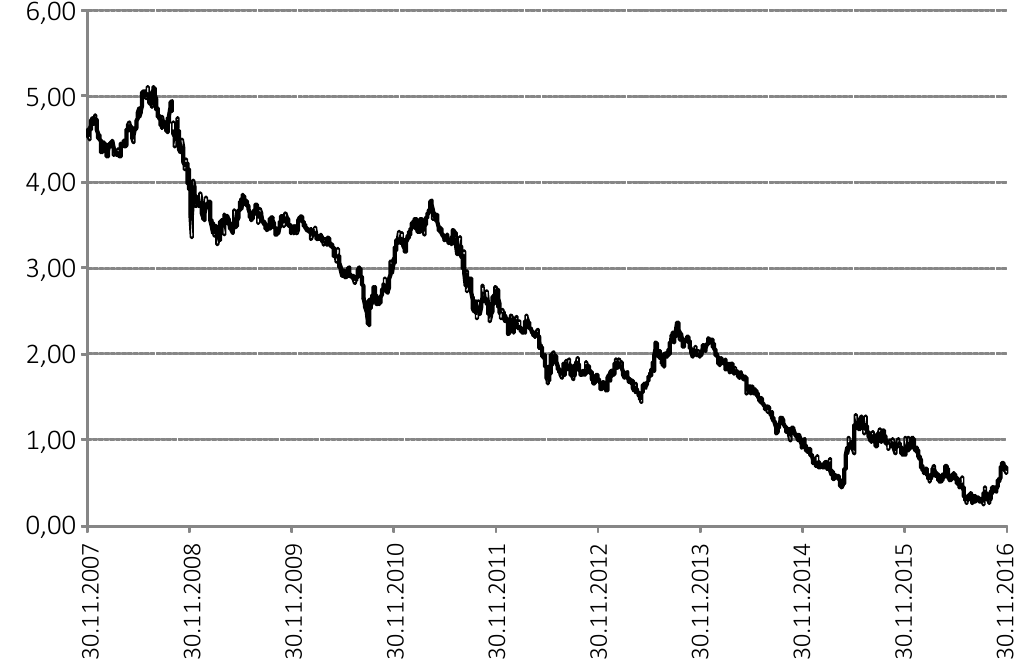
Figure 4. Value of 10 year interest rate swap in EUR